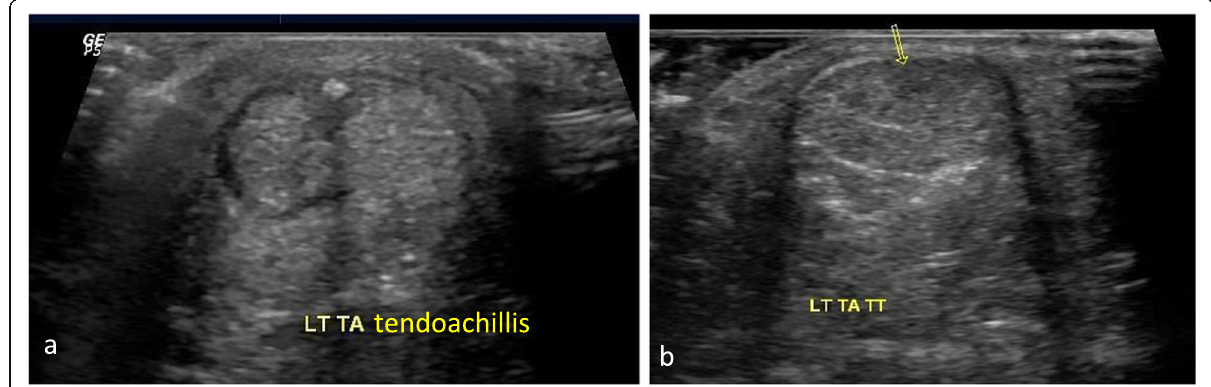
Fig. 2 a Greyscale transverse scan over left Achilles tendon (TA) shows hyperechoic dot of calcification inside the tendon with acoustic shadowing. b After 12 weeks of treatment with